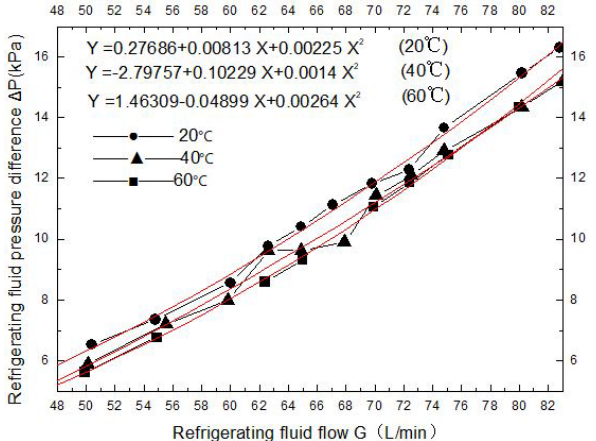
Figure 5. Variation of pressure drop with flow rate (imported pressure 350 kPa ).